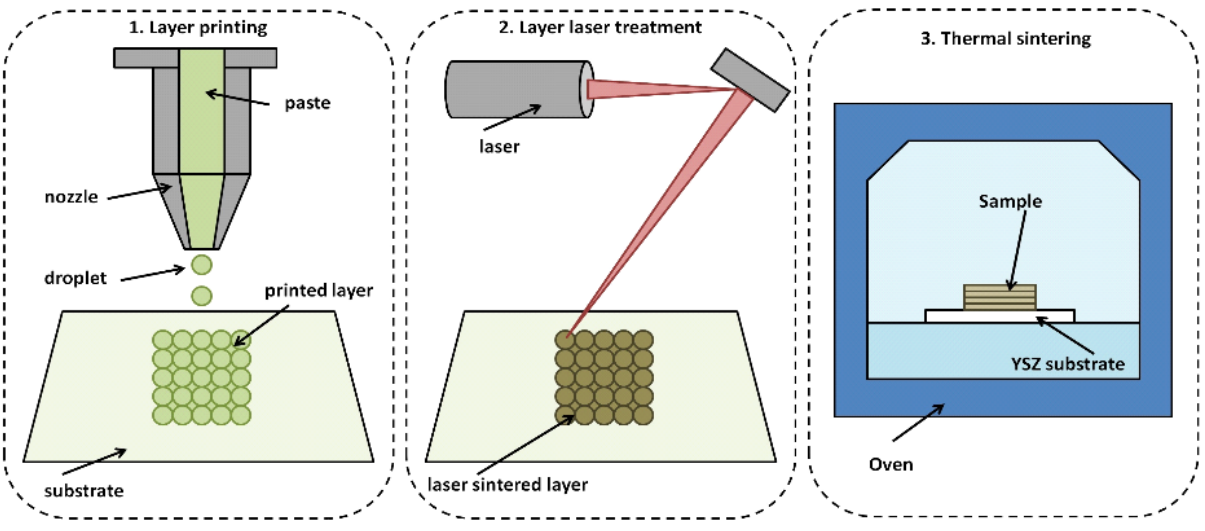
Figure 2. General scheme of the fabrication of anodes by hybrid 3D printing. X-ray diffraction patterns (XRD) of the samples were recorded using a DS Advance powder X-ray diffractometer (Bruker, Karlsruhe, Germany) equipped with a 1D Lynx-Eye detector and Ni-filtered CuK α radiation (0.02 ◦ 2 θ step size, an accumulated time per step of 0.2 s, survey time range from 15 to 80 ◦ ). Quantitative phase analysis was conducted by the Rietveld method [19] using Topas 4.2 software (Bruker AXS, Karlsruhe, Germany) for the profile and structural analysis. The morphology of the samples was analyzed using a Hitachi 3400 N scanning electron microscope (Hitachi, Tokyo, Japan). The paste viscosity was measured using a Brookfield DV3T-RV viscosimeter (Brookfield Engineering Labs, Middleborough, MA, USA) with the cone/plate geometry at 25 ◦ C. The granulometric composition of the samples was analyzed using a SALD-7500nano laser particle analyzer (SHIMADZU Corporation, Kyodo City, Japan). The contents of the pores in the sample were determined by means of ImageJ software using SEM images. The curves of differential thermal analysis (DTA) and the change in the sample mass (TG) were obtained using a STA 449F1 Jupiter synchronous thermal analyzer (NETZSCH, Selb, Germany). The printed sample was heated to 1000 ◦ C in an atmosphere of O 2 /Ar (0.2/0.8) at a rate of 5 ◦